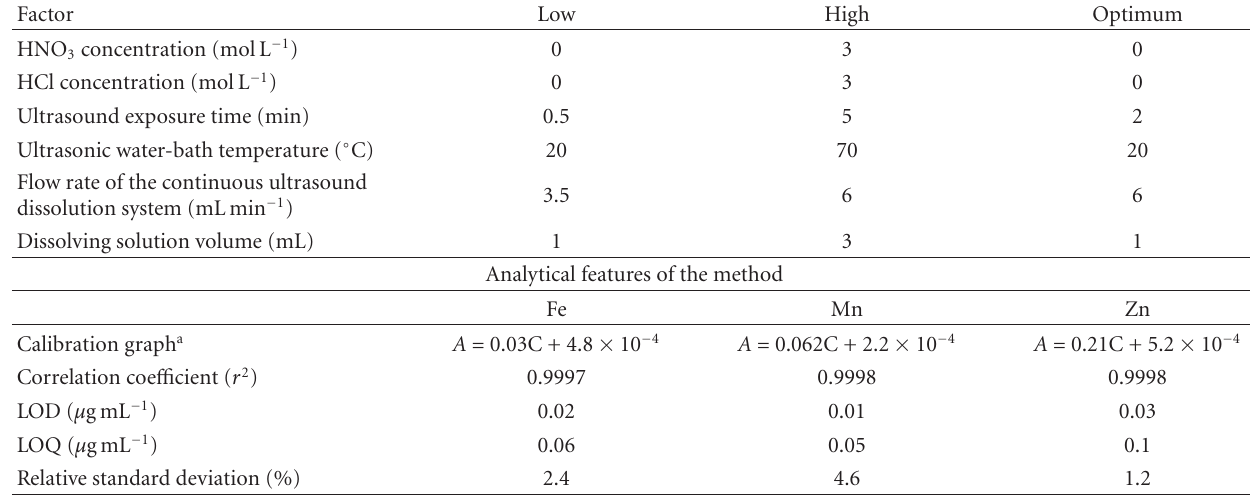
Table 1: Factor levels in the Plackett-Burman factorial design with their optimum values and analytical features of the